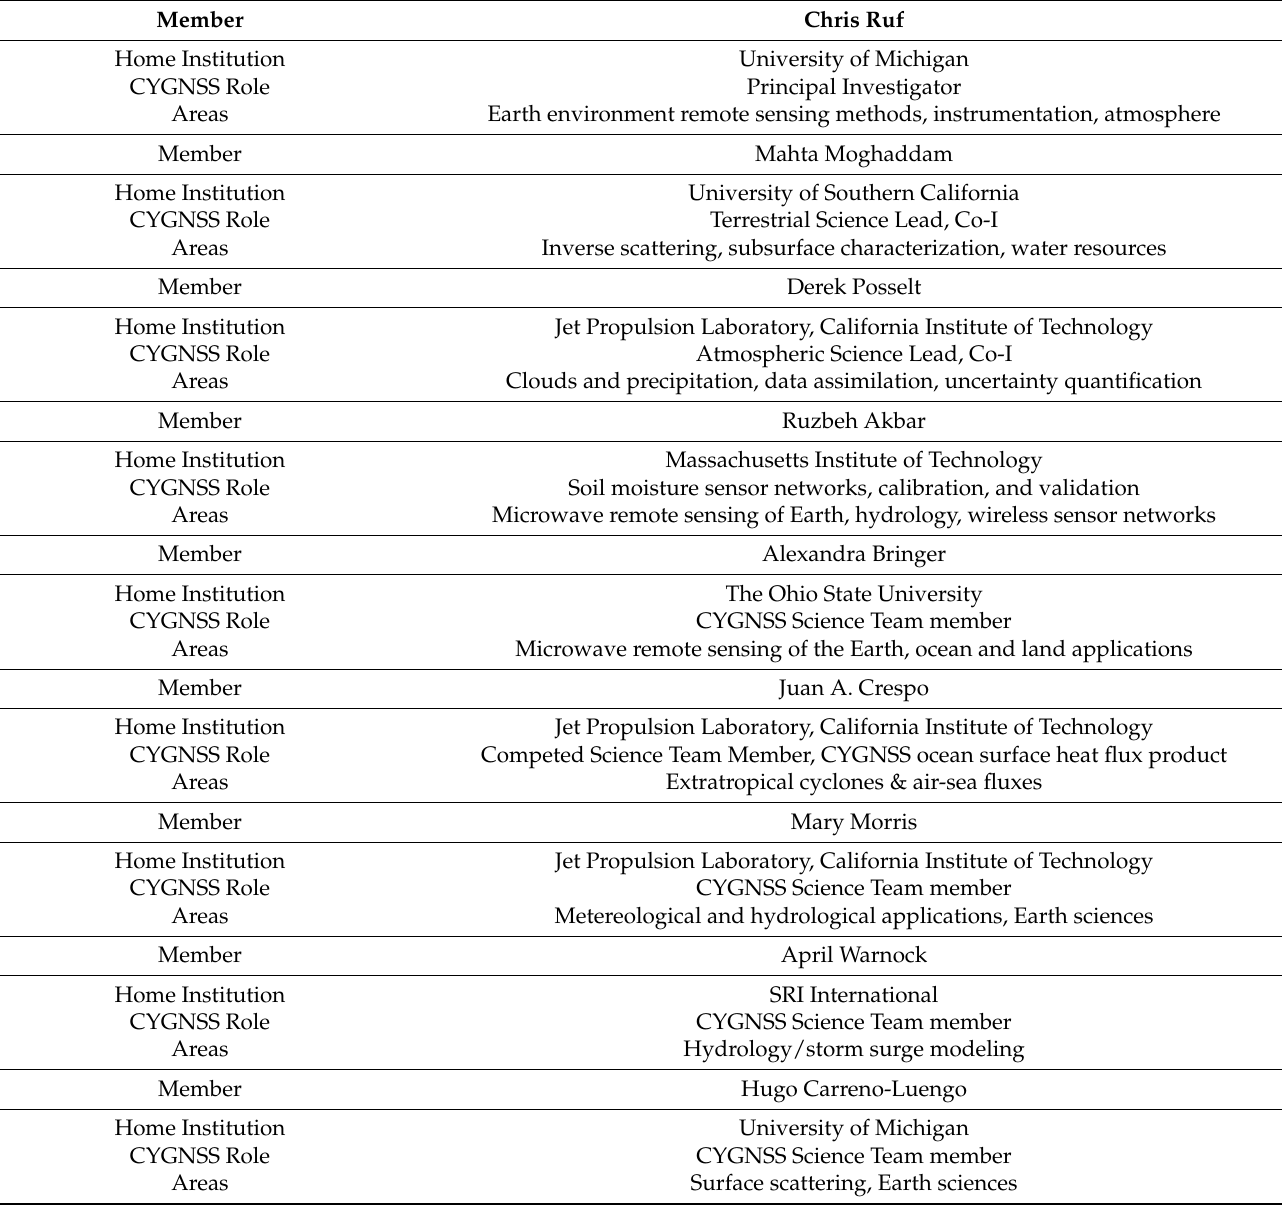
Table 1. Some key-members of the CYGNSS Science Team. The full list is available in